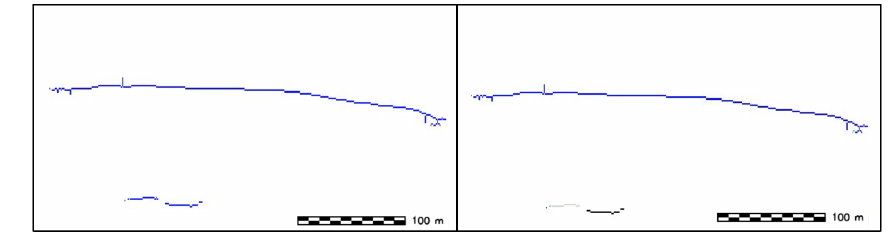
Figure 9. SWC clumping.